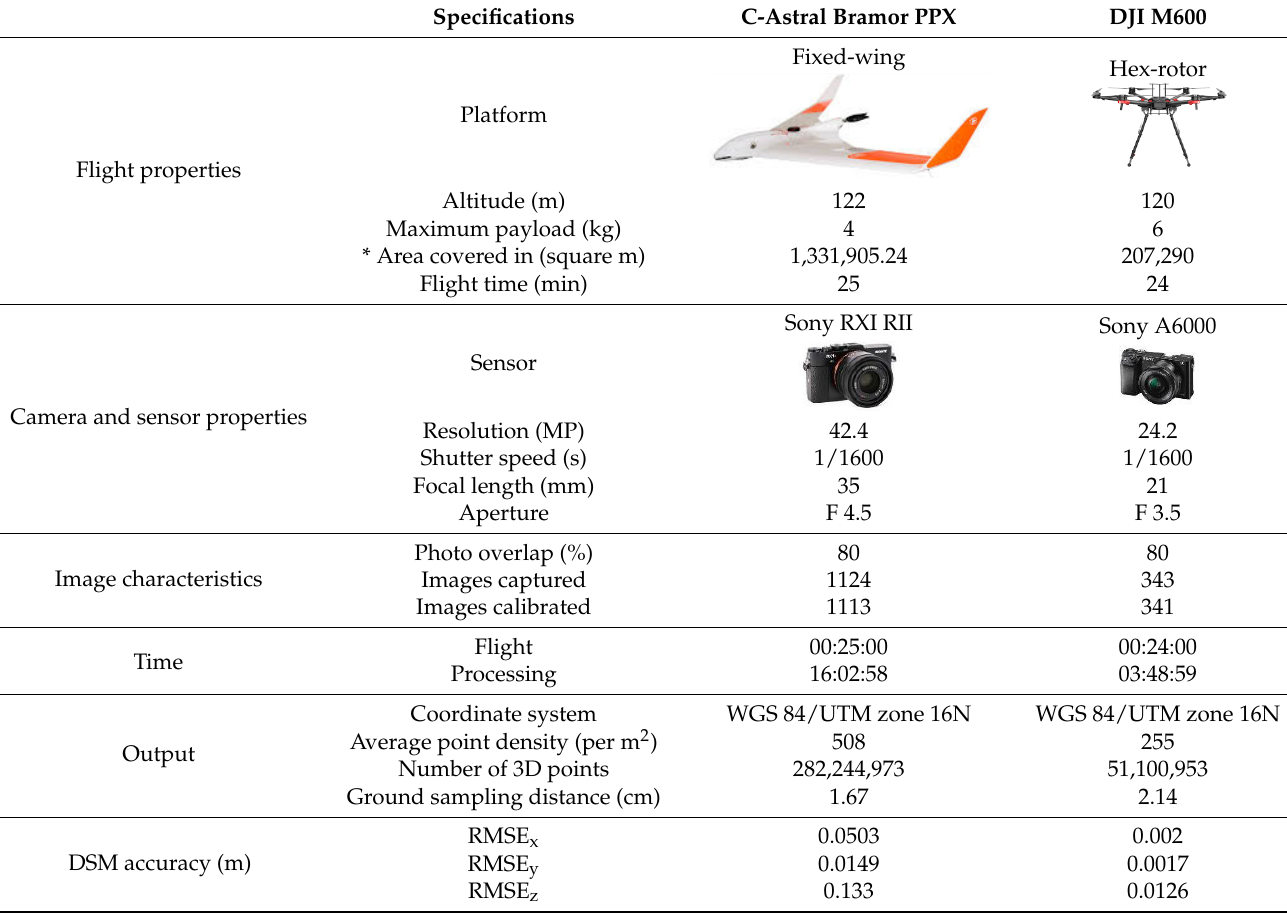
Figure 1. Orthomosaic and point cloud illustration of the two plantations in this study, ( a ) red oak plantation and ( b ) black walnut plantation, with their tree height statistics, at Martell Forest, Indi- ana. Table 2. Summary of parameter specifications for two platforms and sensors used for this study.